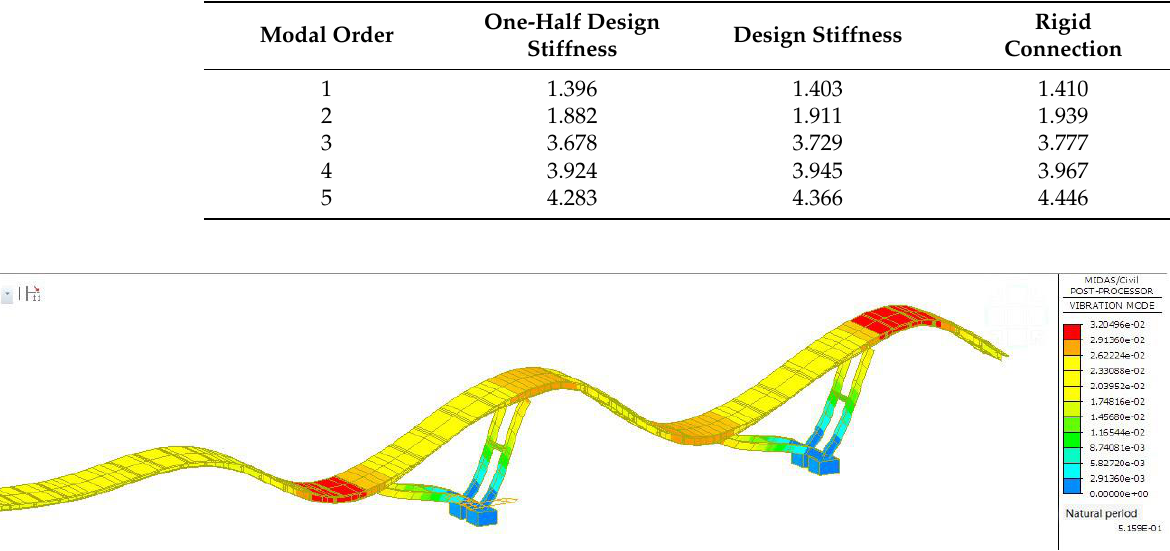
Figure 14. First-order vertical vibration diagram of rigid connection /m.